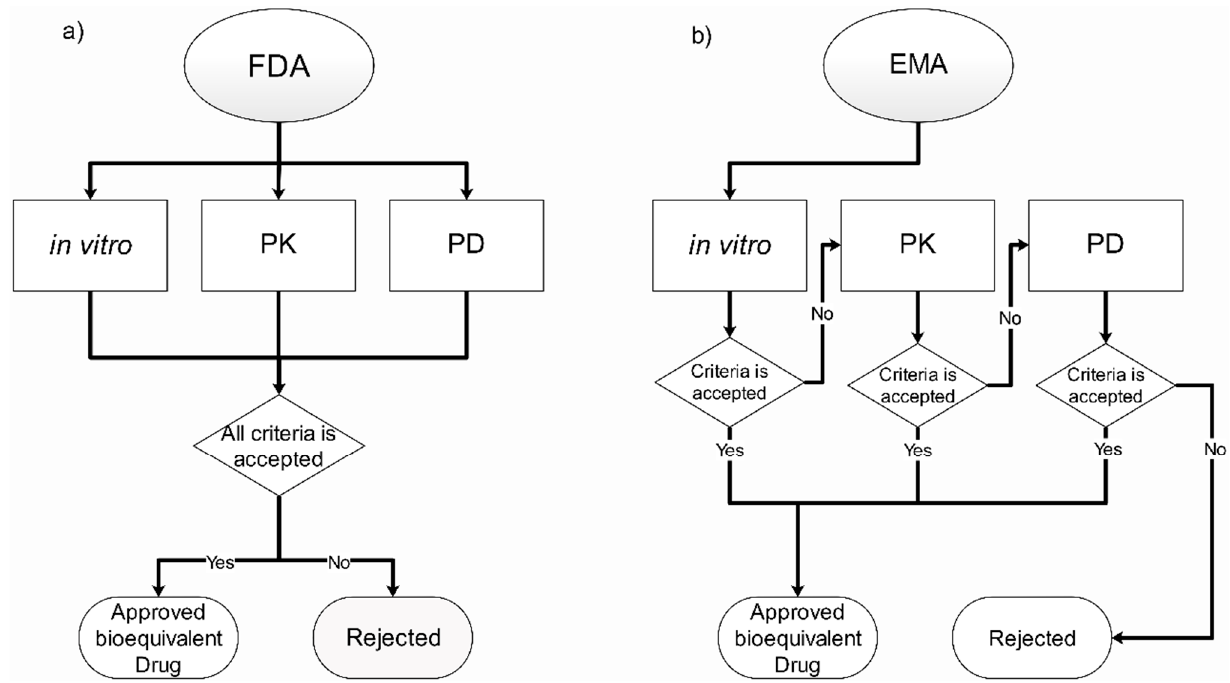
Figure 3. Overview and comparison of the current regulation for bioequivalence in orally inhaled drugs in the ( a ) U.S. Food and Drug Administration (FDA) and ( b ) the European Medicines Agency (EMA) [23–25].